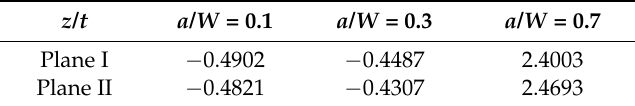
Table 3. Solutions of normalized T -stress ( V ) for 3D SECP under biaxial loading, λ = 1.0, in plane I and